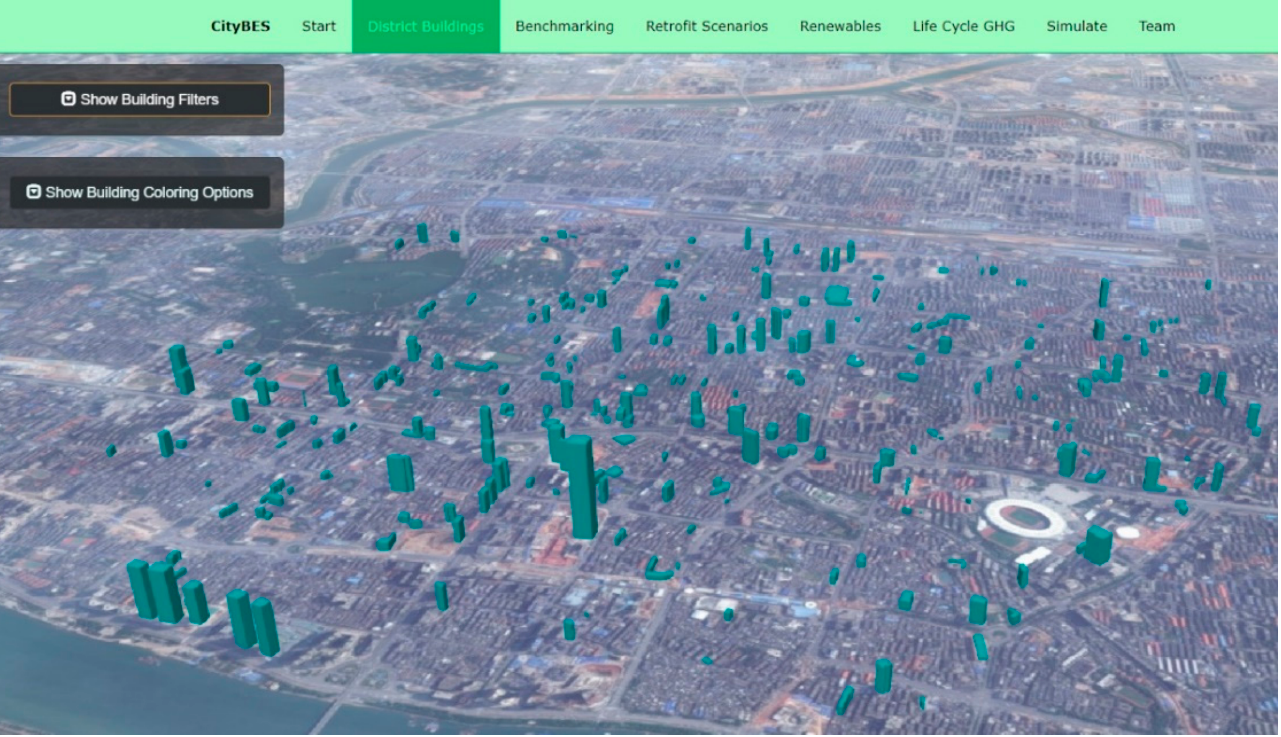
Figure 8. Office buildings in downtown